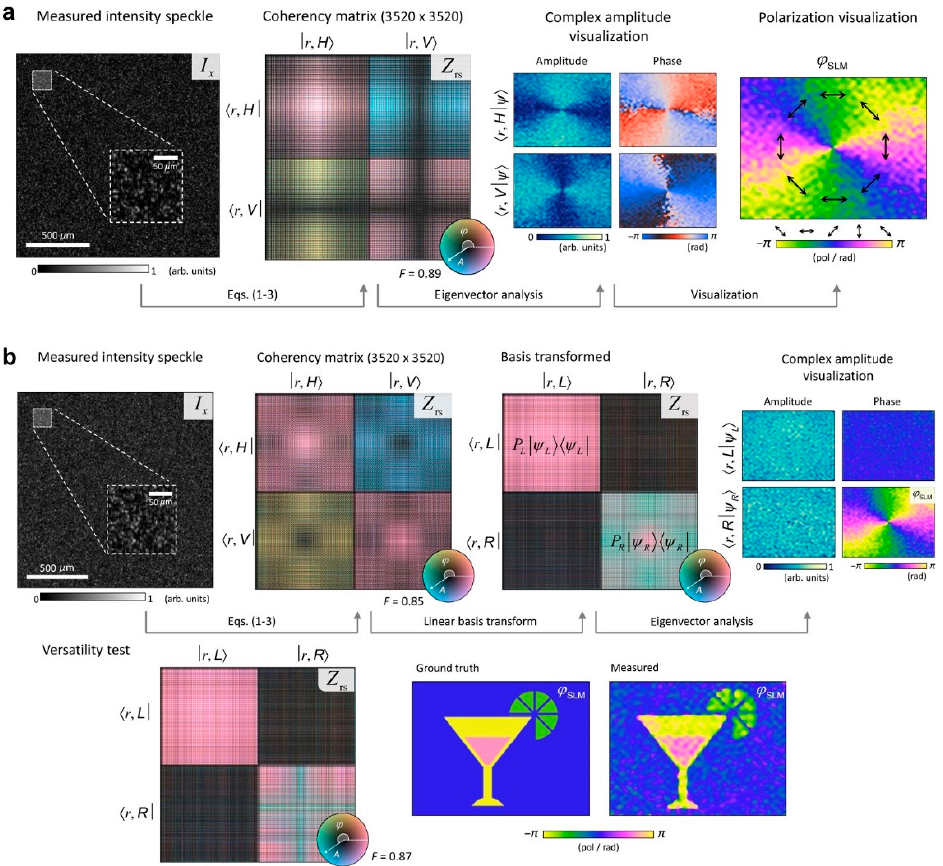
Figure 6. Coherency matrix and SSM. ( a , b ). SSMs measured from speckle patterns of polarized ( a ) and unpolarized light ( b ) become coherency matrices. A and ϕ are the amplitude and phase of light, respectively; I x , is the measured intensity speckle in camera ( x ) domain; Z rs is the measured SSMs in the space–polarization ( r and s , respectively) domain; H , V , L , and R are horizontal, vertical, left-circular, and right-circular polarizations, respectively; P L and P R are the statistical weight for the L and R polarizations, respectively; and ( ) , , r L r L ψ ψ= and ( ) , , r R r R ψ ψ= are the holographic images for the L and R polarizations, respectively. For both coherent and incoherent states of light, holographic images of two orthogonal polarizations are measured. Adapted with permission from [67], APS.